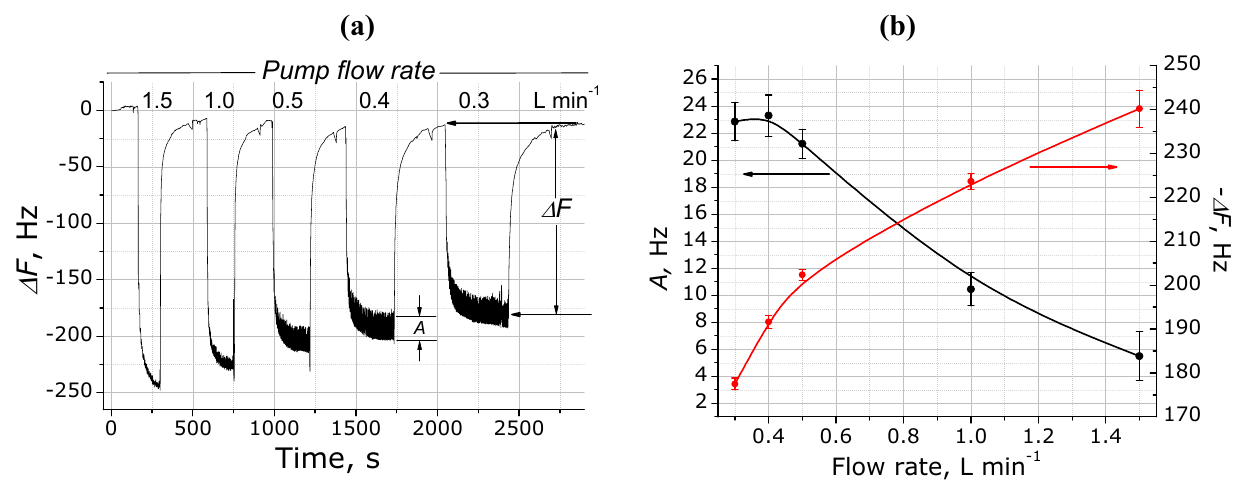
Figure 3. (a) QCM sensor response to human respiration when different pump flow rates applied. (b) Frequency shift and amplitude of response oscillations due to respiration dependency on the pump flow rate for consecutive breathing episodes of the same person within the same measurement session: open red circles, frequency shifts  F ; closed